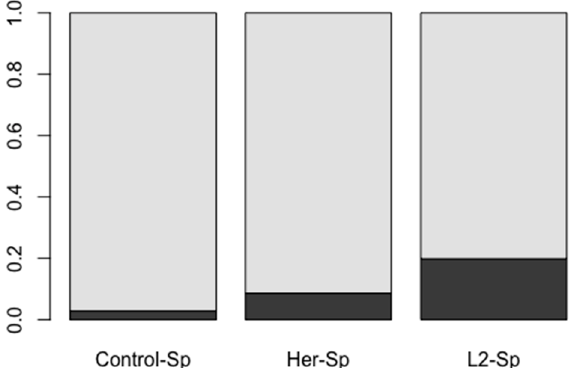
Figure 1. Proportion of correct (grey) and incorrect (black) answers by Spanish language status. A mixed effects logistic regression was run on the effect of the segment (/e / vs. /ei/) and Spanish language status (control primary Spanish vs. heritage Spanish learners vs. L2 Spanish learners) on the responses for the task (Table 4). The reference levels were native Spanish and / e/. Significance codes: <0.001 ‘***’; <0.01 ‘**’; <0.05 ‘*’. Table 4. Glmer model for segment and Spanish language status.